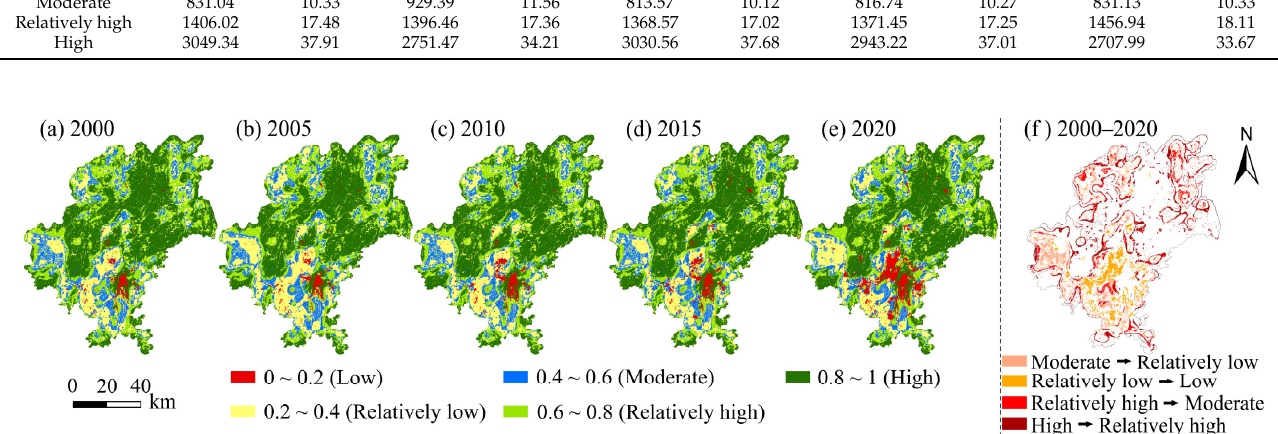
Figure 3. Spatial variation of habitat quality in Guiyang from 2000 to 2020.